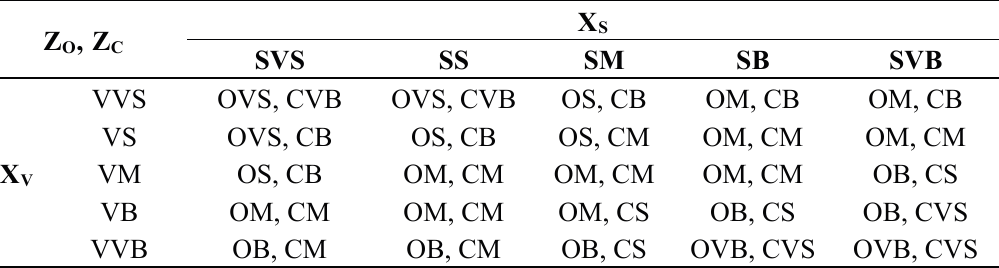
Table 4. Open/Close time fuzzy rule table.